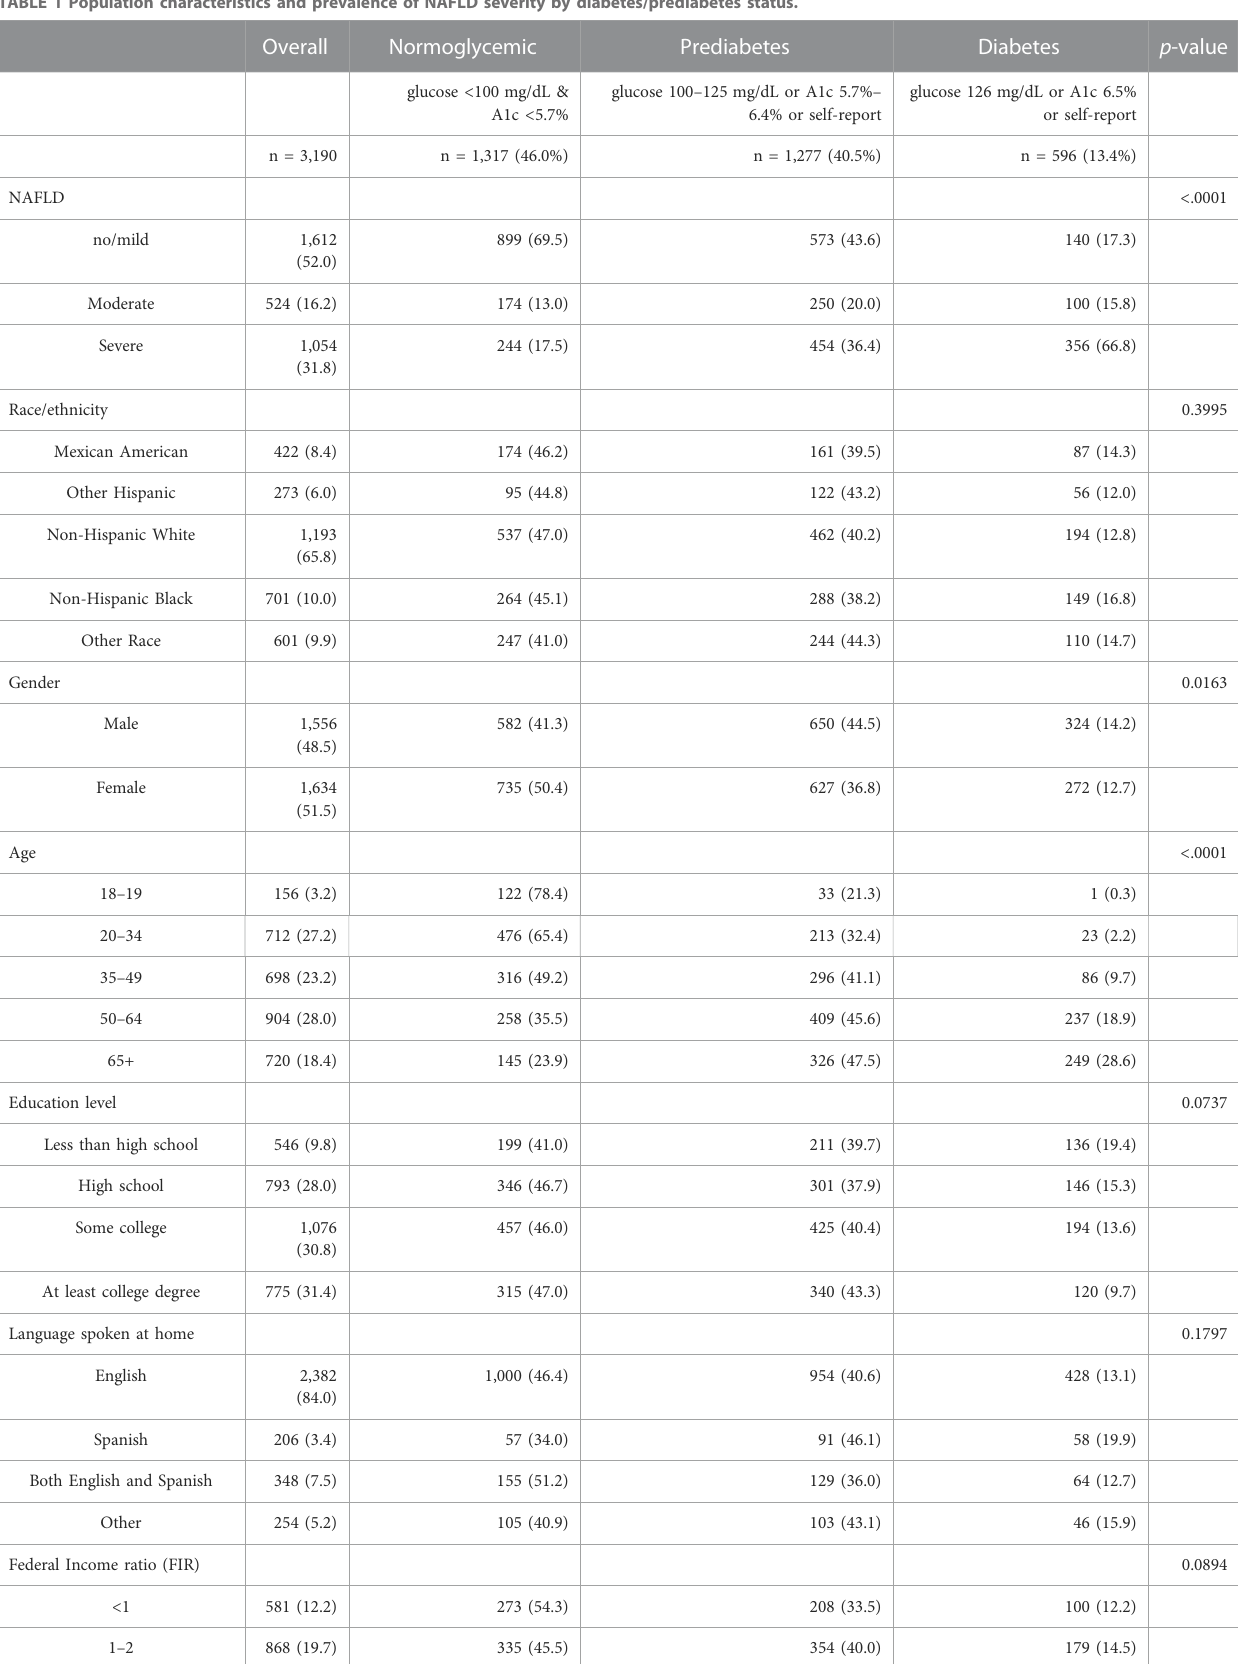
TABLE 1 Population characteristics and prevalence of NAFLD severity by diabetes/prediabetes